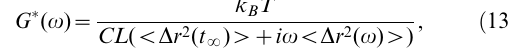
where r i are the RBC vertex coordinates, r C is the center-of-mass, and m , n can be x , y , or z . The eigenvalues of the gyration tensor characterize the RBC shape so that in equilibrium the smallest eigenvalue corresponds to the RBC thickness. At the biconcave-to- parachute transition the smallest eigenvalue becomes larger since the RBC elongates along the flow axes. Figure 9 shows the dependence of the shifted eigenvalue (the shift is done by subtracting the eigen-value of the equilibrium biconcave shape) of the gyration tensor for healthy and Pf-RBCs. The dashed line marks the biconcave-to-parachute transition as a function of the mean flow velocity. The transition for healthy RBCs occurs at a